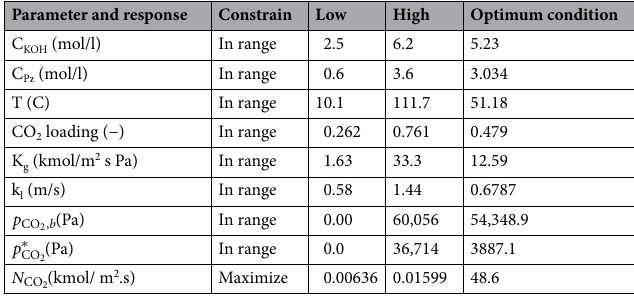
Table 4. Optimization of the CO 2 absorption by RSM-CCD.